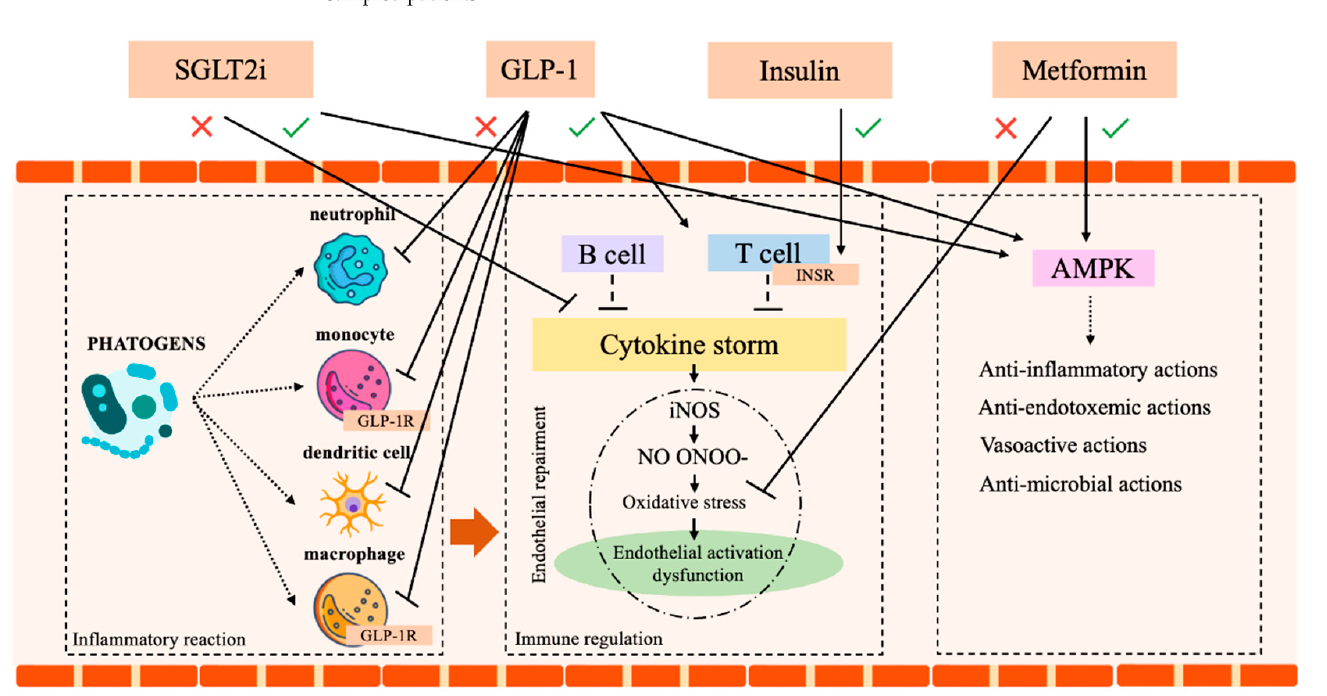
Figure 3. Immune system and insulin, metformin, SGLT2 and GLP-1 action. AMPK (AMP-activated protein kinase), SGLT2 (sodium-glucose co-transport 2 inhibitors), GLP-1 (Glucagon-like peptide-1 receptor agonists), GLP-1R (Glucagon-like peptide-1 receptor), T reg1 (T regulator 1 lymphocytes), INSR (Insulin receptor). Icon design by icons8.